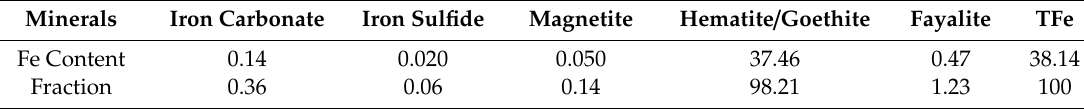
Figure 2. Microstructure of the HAIO (G-Goethite, H-Hematite, K-Kaolinite). Table 2. Distributions of iron in mineral phases of the HAIO (wt. Table 4. The EDS analysis results for areas in Figure 2. Area No.